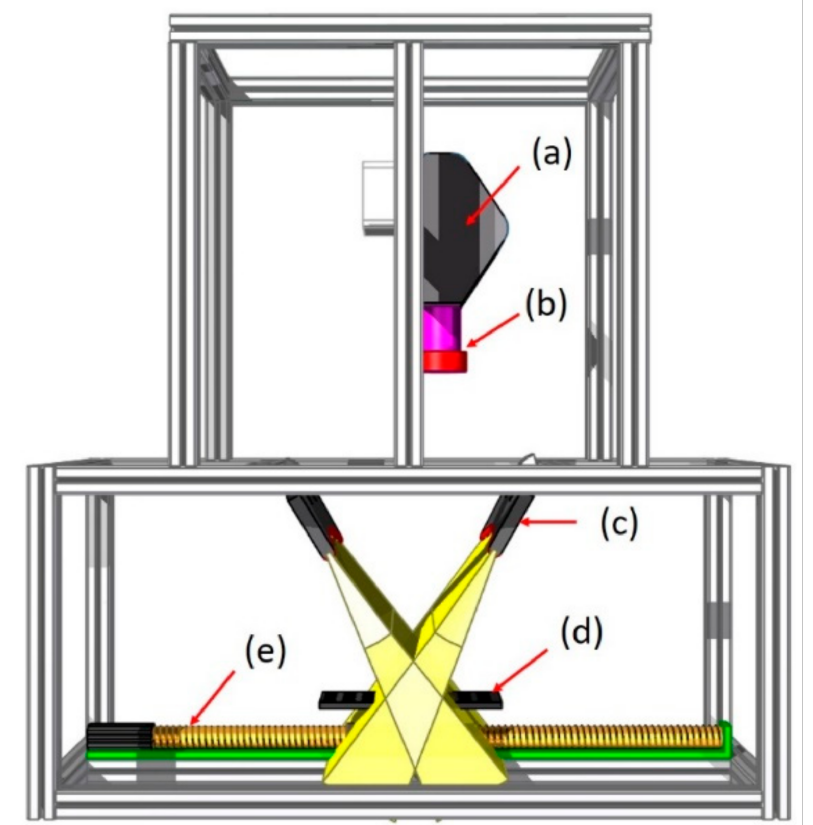
Figure 1. Conceptual diagram of HSI system: ( a ) imaging spectrograph with electron-multiplying CCD, ( b ) C-mount lens, ( c ) quartz–tungsten halogen lamps, ( d ) sample holder, and ( e ) programmable monoaxial